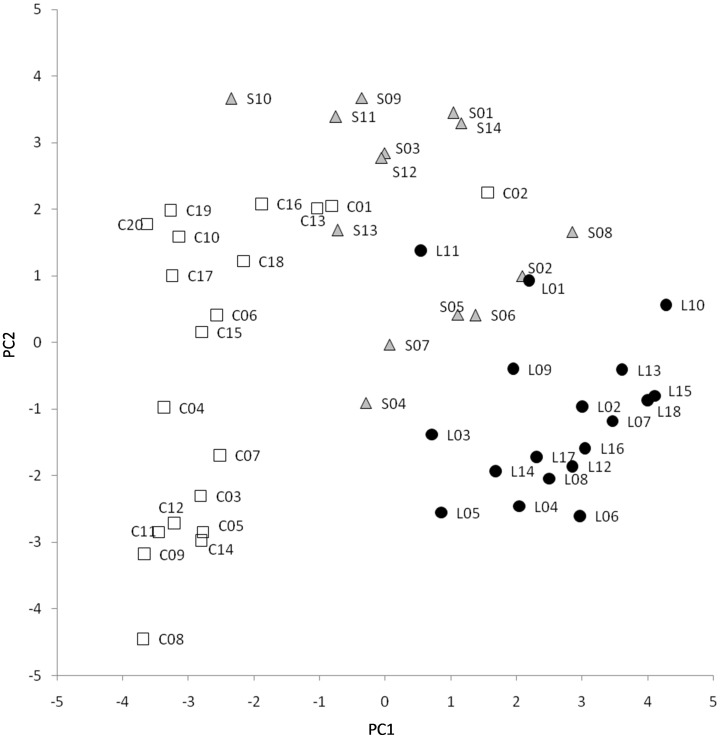
PCA morphology-based relationships between accessions.A total of 52 S. melongena accessions from China (white squares), Spain (grey triangles), and Sri Lanka (black circles) (Table 1) were morphologically evaluated with 28 morphological traits (see text and Table 2) and were represented on the two first components (PC1 and PC2) of the principal components analysis (22.9% and 16.2% of the total variation explained by the first and second component, respectively).